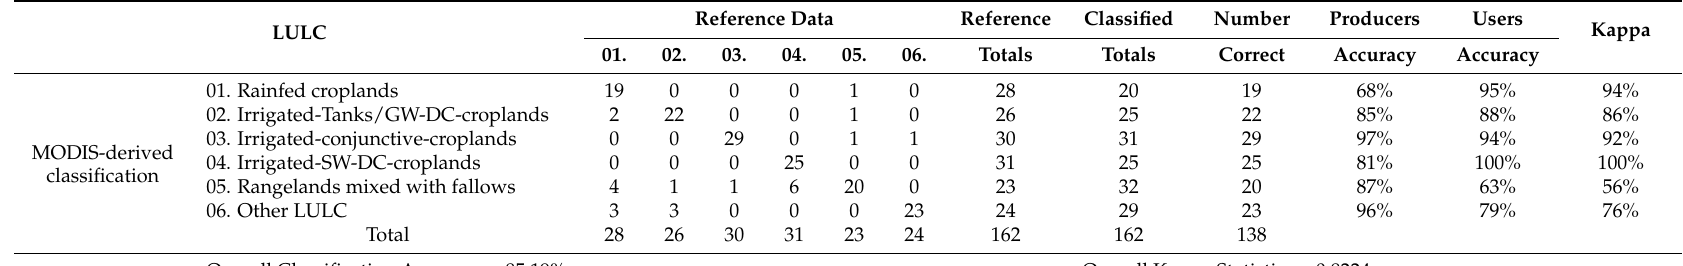
Table 6. Accuracy assessments done using error matrix for LULC classes of 2015–2016.